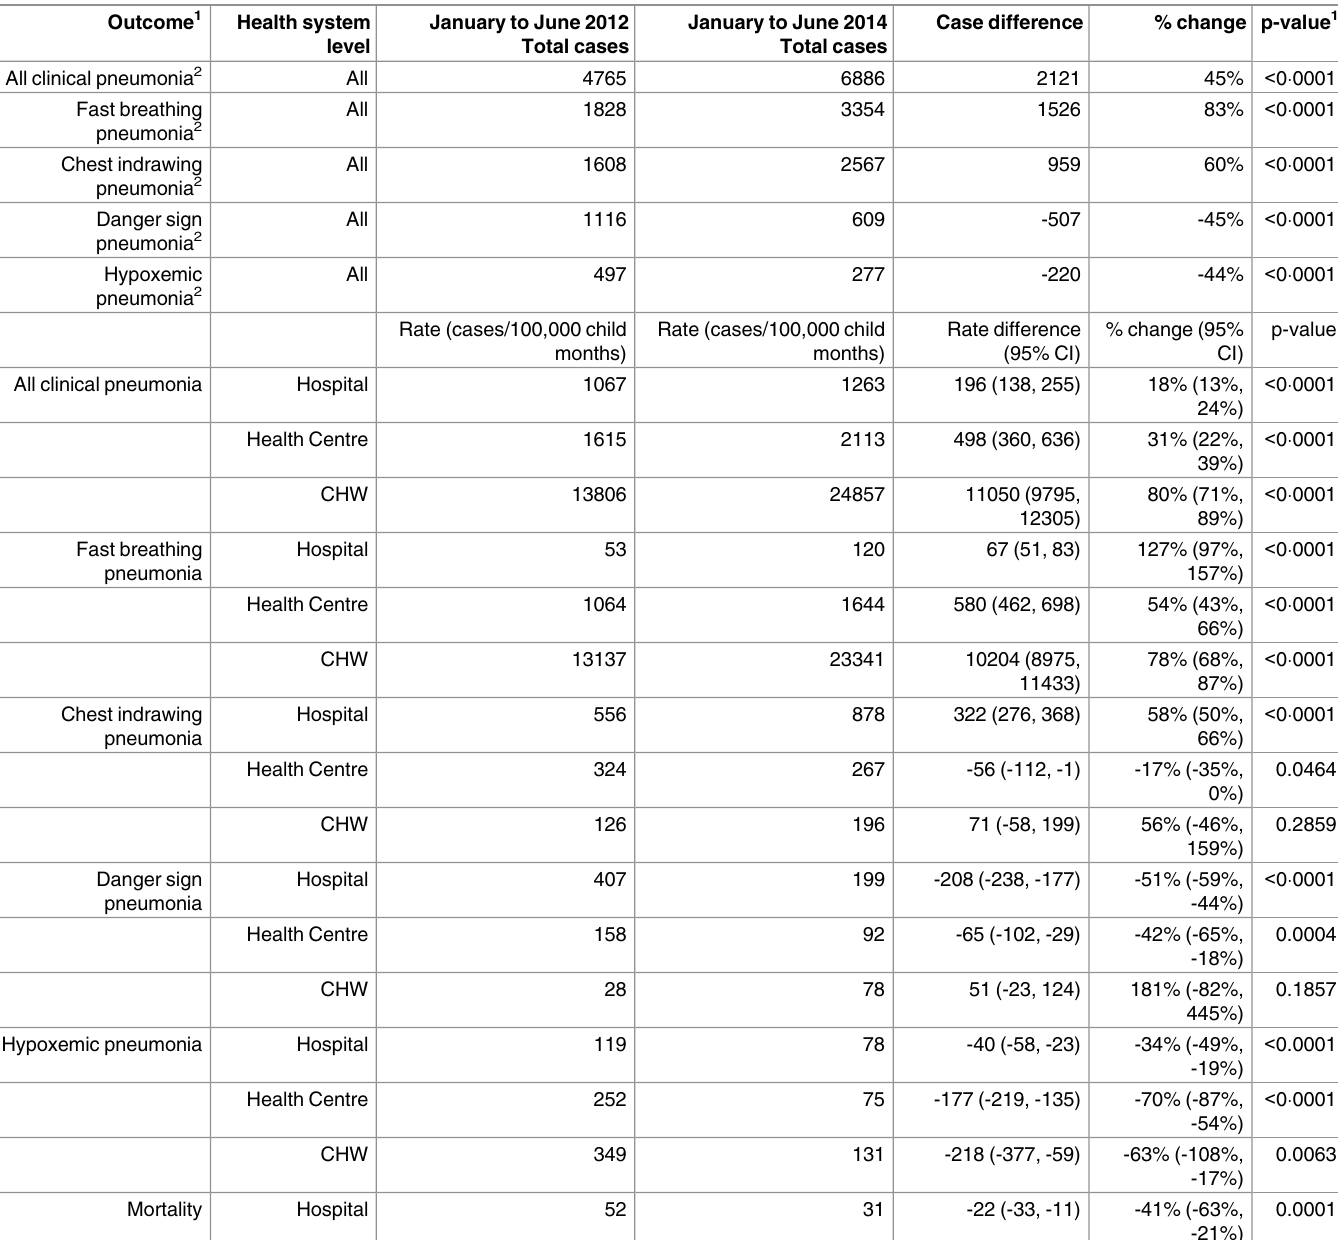
Table 3. Changes in case burden of clinical and hypoxemic pneumonia in children (0–59